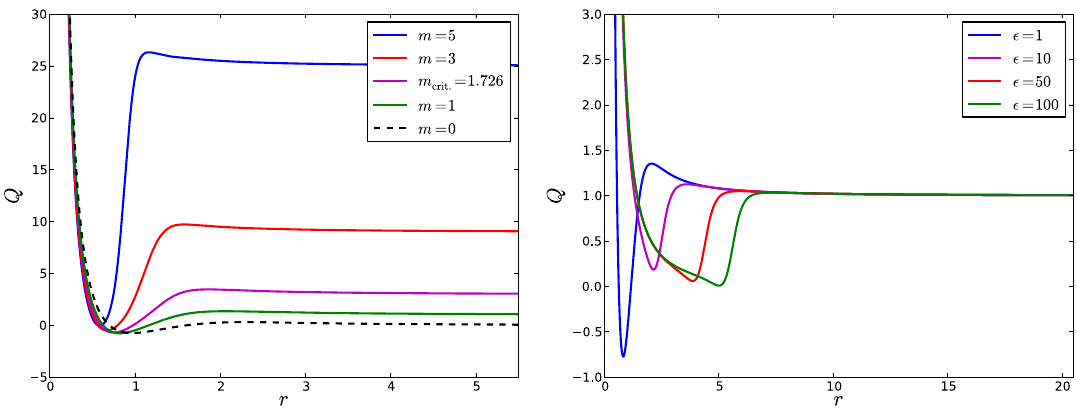
Figure 11 . E(cid:11)ective potential Q for the L 2460 Skyrme model with the usual Skyrme potential. Left: (cid:15) = 1 and di(cid:11)erent value of the mass m . Right: m = 1 and di(cid:11)erent values of (cid:15) .